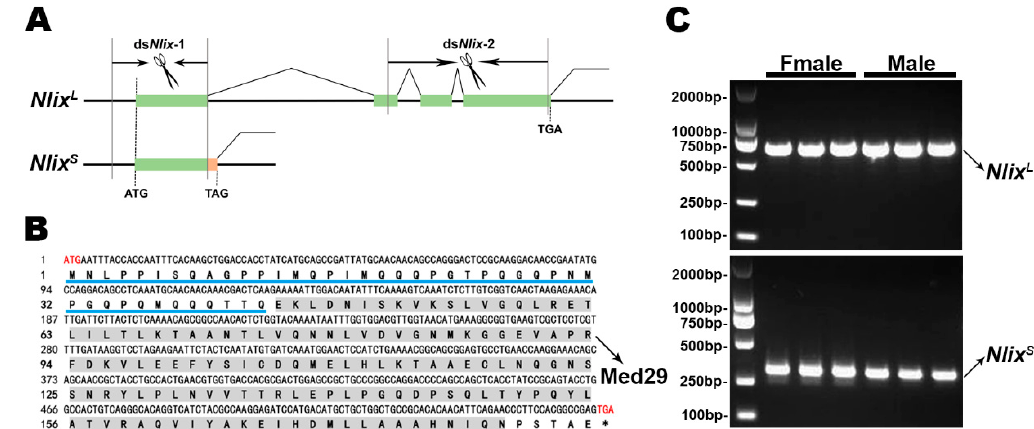
Figure 1. Alternative splicing pattern of Nlix . ( A ) Structural schematic of the two Nlix isoforms. Boxes and lines denote exons and introns, respectively. Green boxes: common region of the two isoforms and the specific region of Nlix L . Orange box: the specific region of Nlix S . Scissors indicate two regions as RNAi targets on the Nlix L . ( B ) cDNA and corresponding amino acid sequence of Nlix . The glutamine-, methionine-, proline-, and glycine-rich regions are underlined and the highly conserved region (Med29) of IX homologs is highlighted in gray. ( C ) Non-sex specific expression of the two Nlix splicing variants.